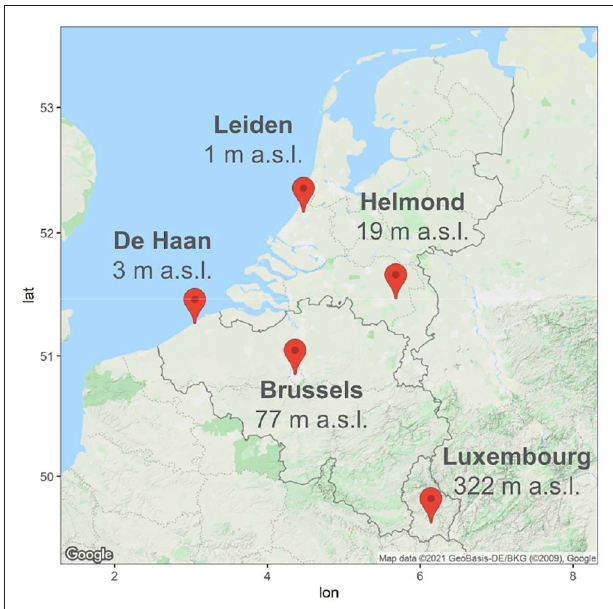
FIGURE 1 | Map of the selected monitoring stations. Corresponding city name and altitude above sea level (a.s.l.) expressed in meters.